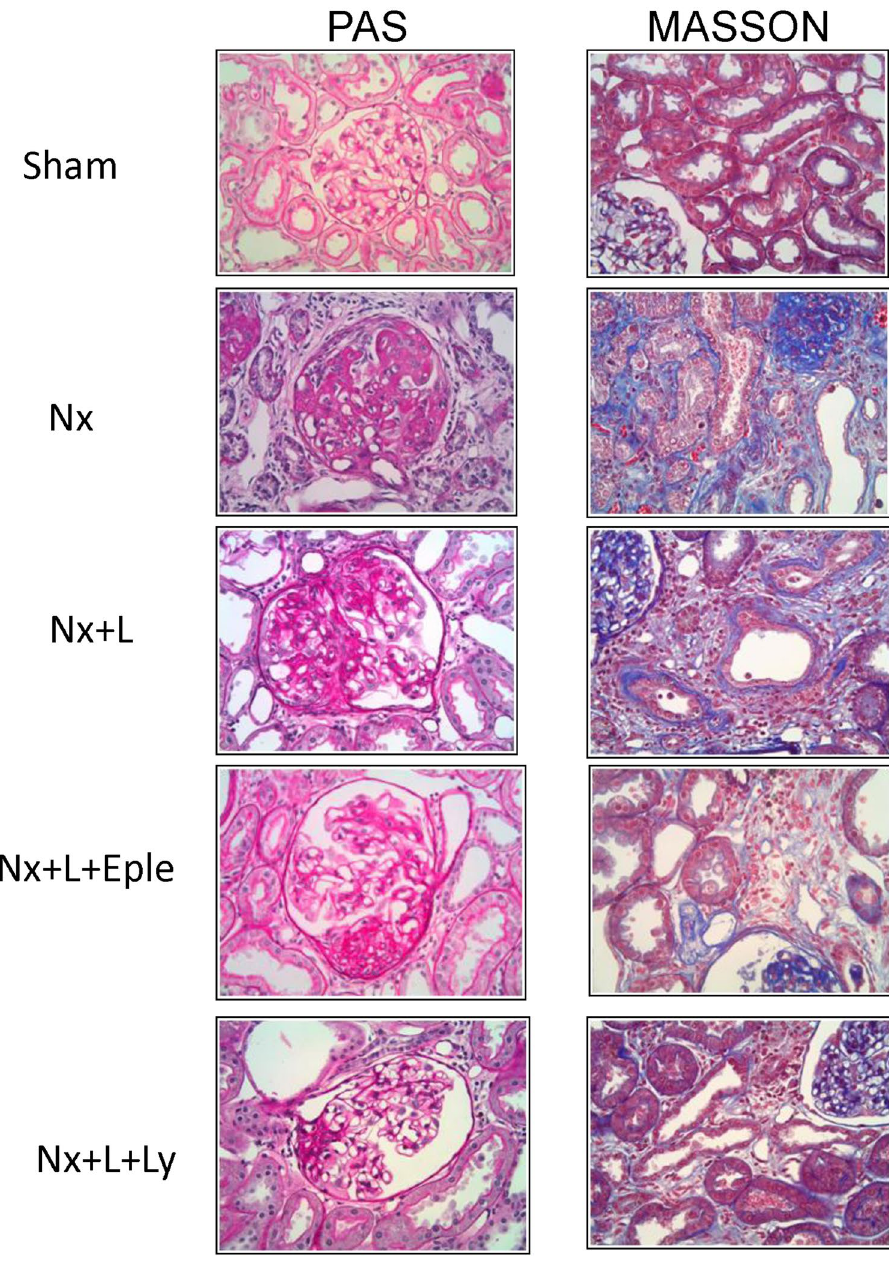
Figure 6. Representative photomicrographs of PAS-stained (for glomerulosclerosis) and Masson-stained (for cortical interstitium) renal tissue in the five groups studied in Protocol 2